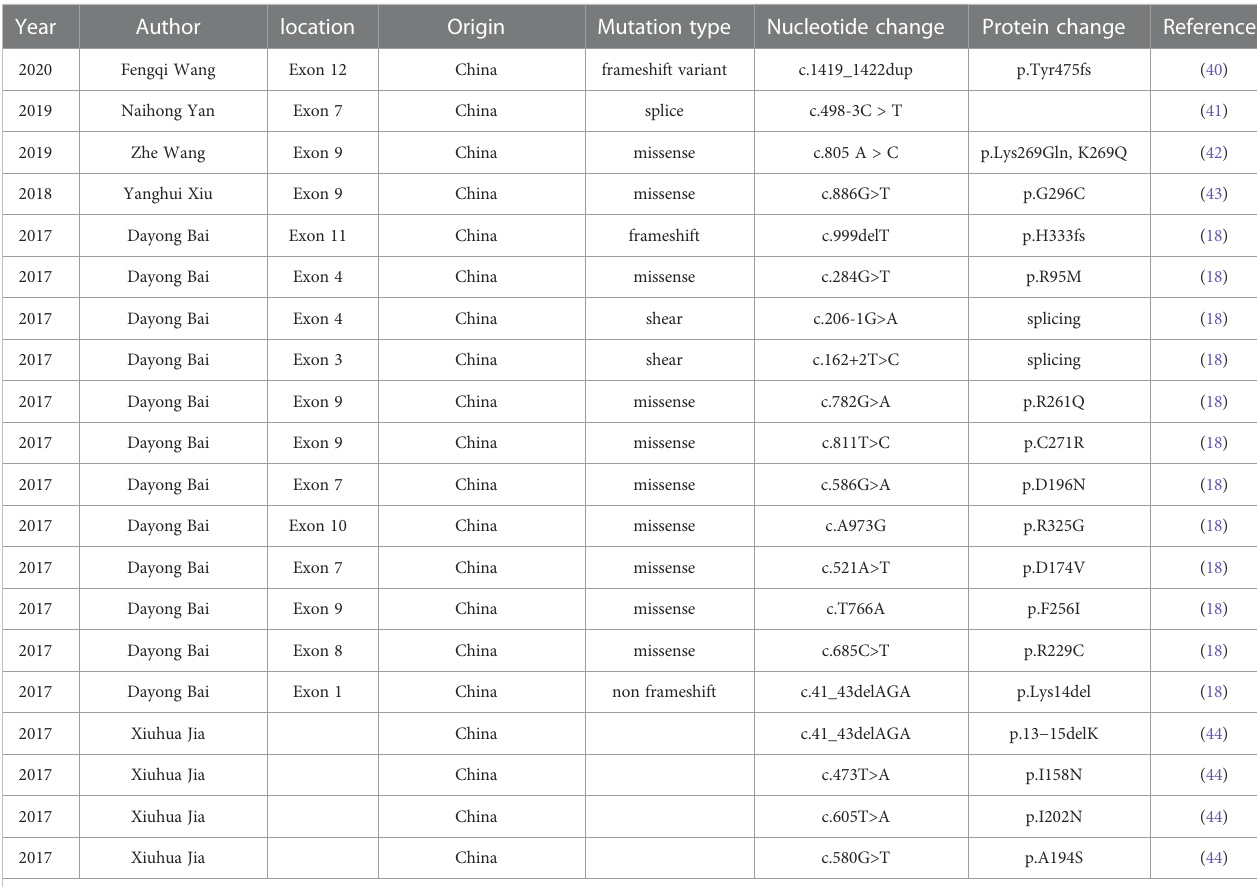
TABLE 1 Summary of the cases of FRMD7 mutation in